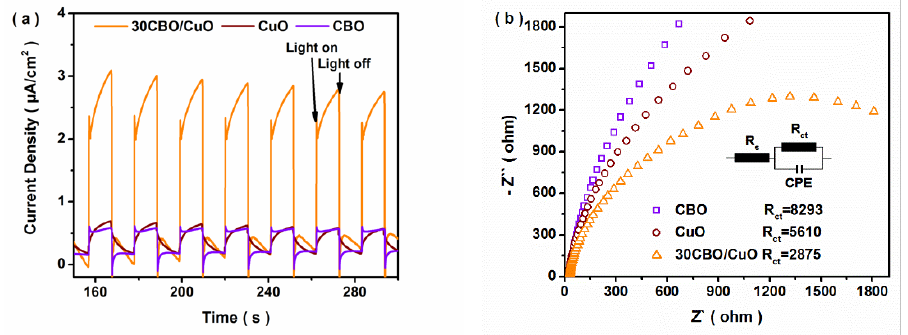
Figure 6. ( a ) I-t curves and ( b ) EIS Nyquist plots of CBO, CuO and 30CBO/CuO samples.